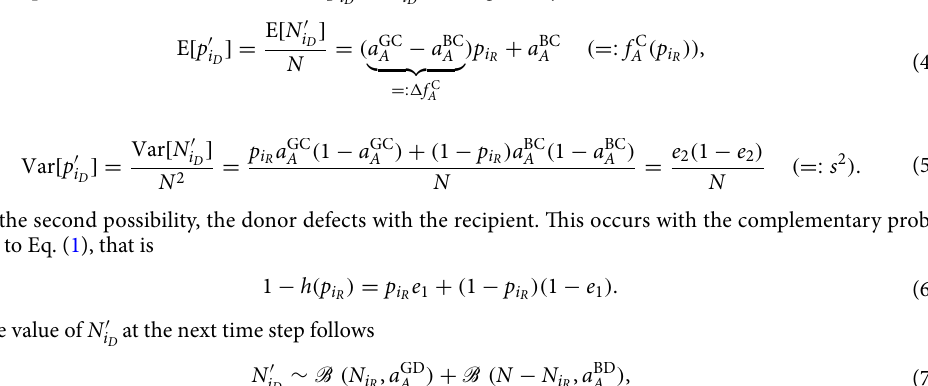
Table 2 for their values. The expected value and the variance of p ′ i